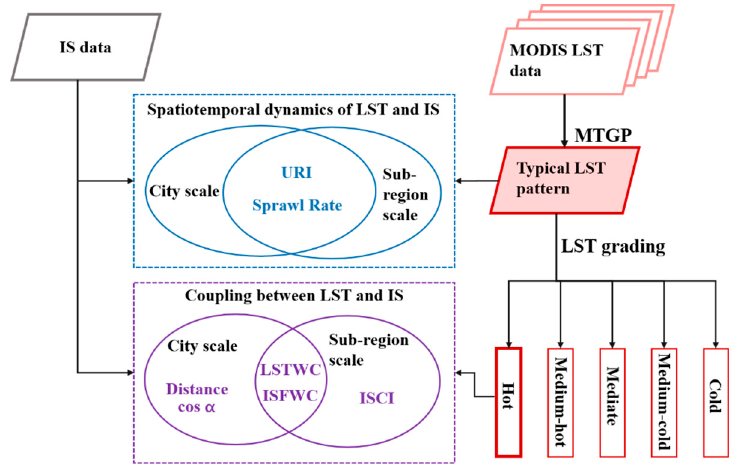
Figure 2. The technical flow of this study.